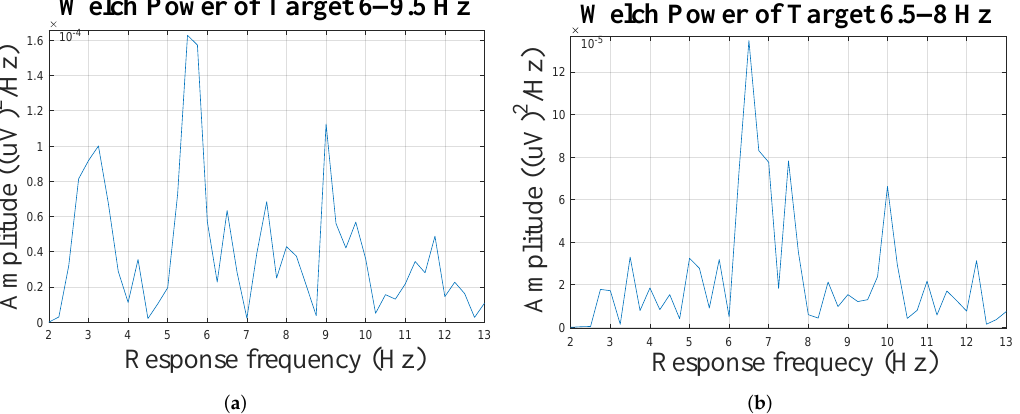
Figure 4. ( a ) The PSD plot based on aggregated SSmVEP with 6–9.5 Hz target frequencies. ( b ) Similar to ( a ) but with 8–6.5 Hz target